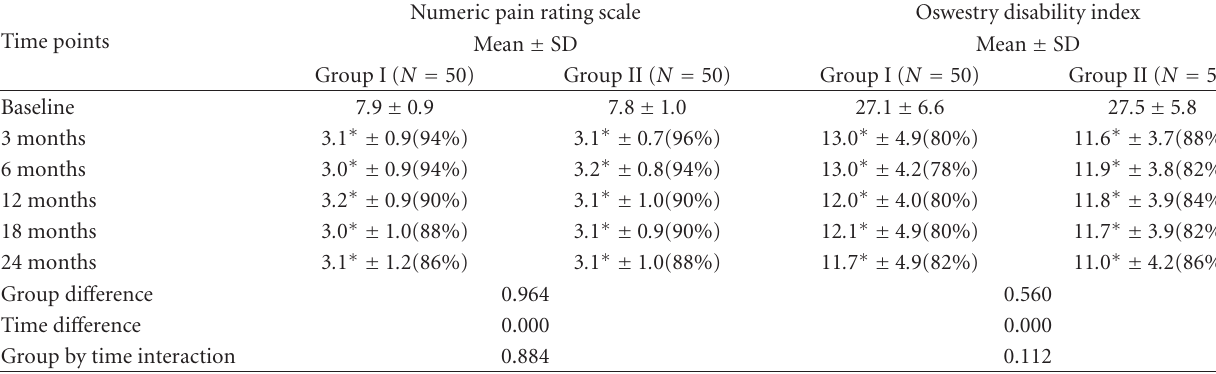
Table 2: Comparison of numeric rating scale for pain and Oswestry Disability Index score summaries at four time points.